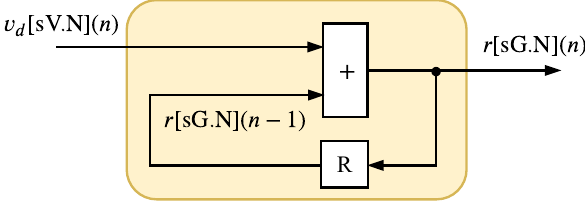
Figure 13. Hardware architecture of the IM.